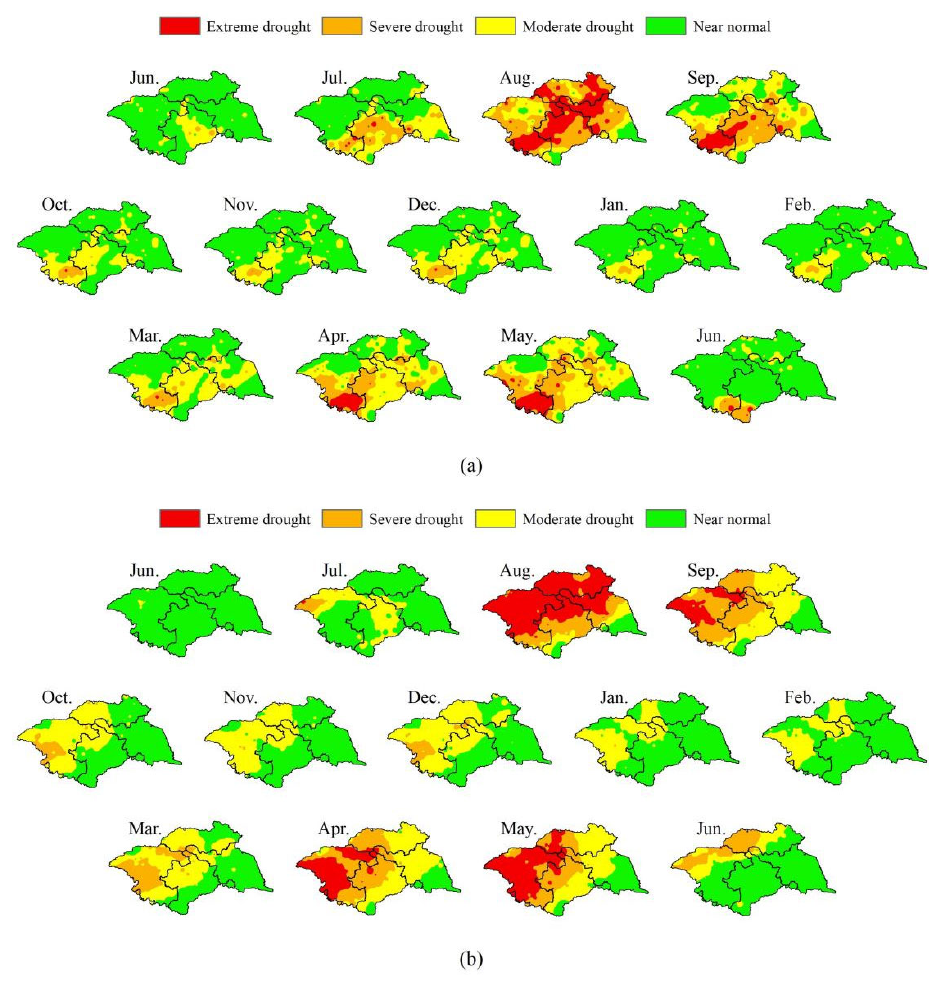
Figure 14. Spatial distribution maps of SPI ‐ 12 from ( a ) gauge; and ( b ) PERSIANN ‐ CDR for the 1999–2000 drought event.